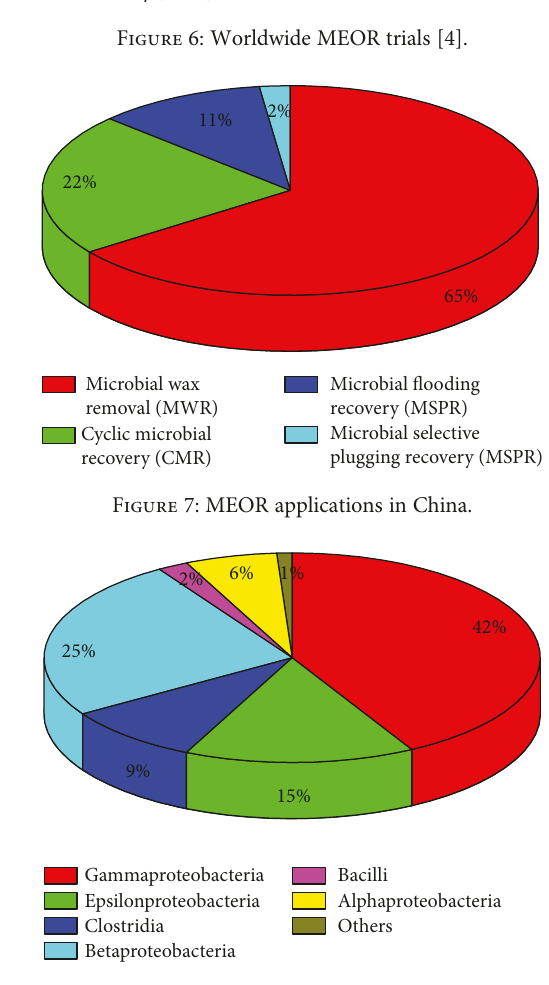
Figure 8: The diversity of bacteria in oil reservoirs